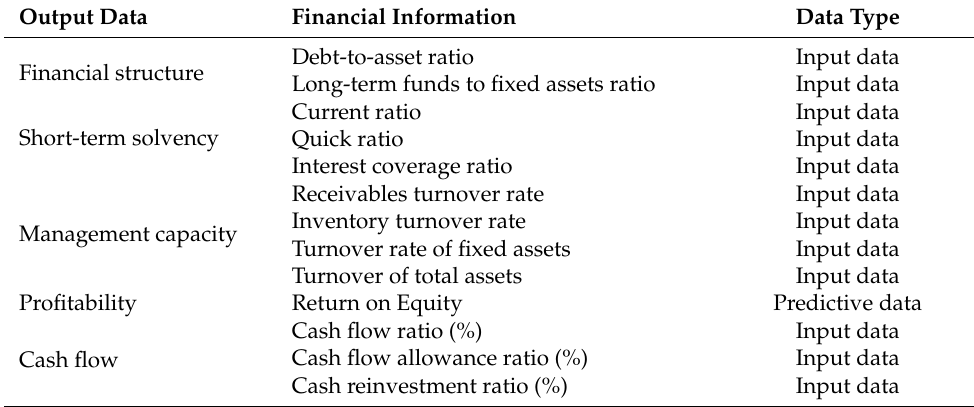
Table 1. Financial information attribute in each enterprise.